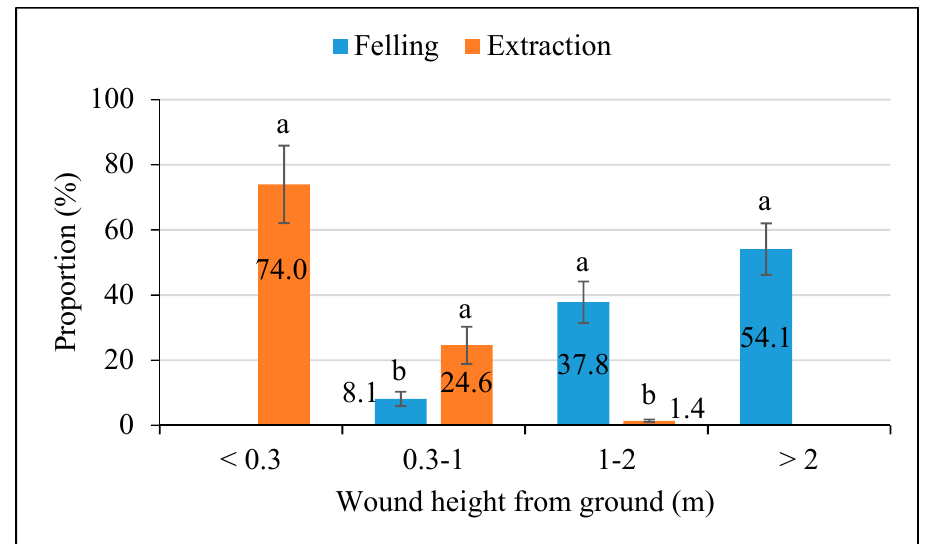
Figure 3. Proportion (%) of felling and extraction operations in the occurrence of bole wounds at different heights from ground level.